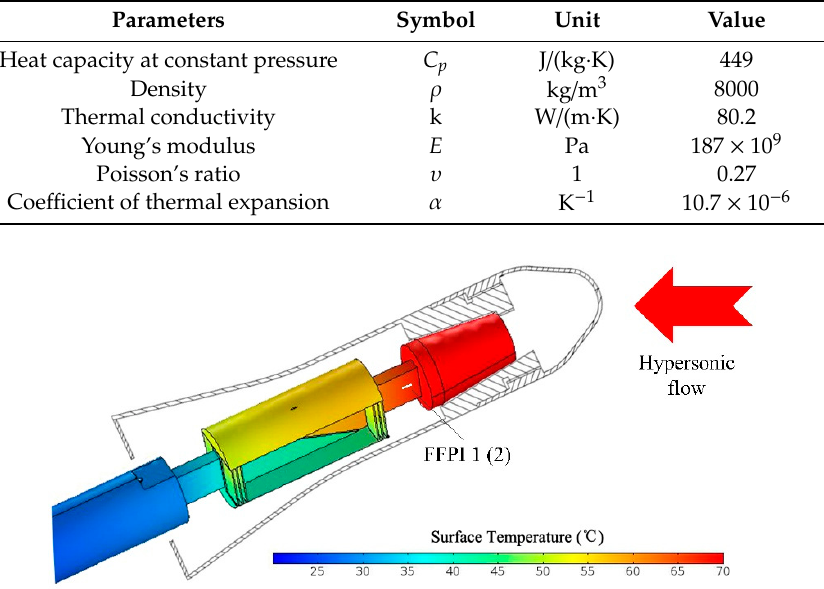
Figure 11. Temperature simulation of the balance, with an angle of attack (AoA) of 30°, and the tunnel model is assumed to be heated up to 70 °C.